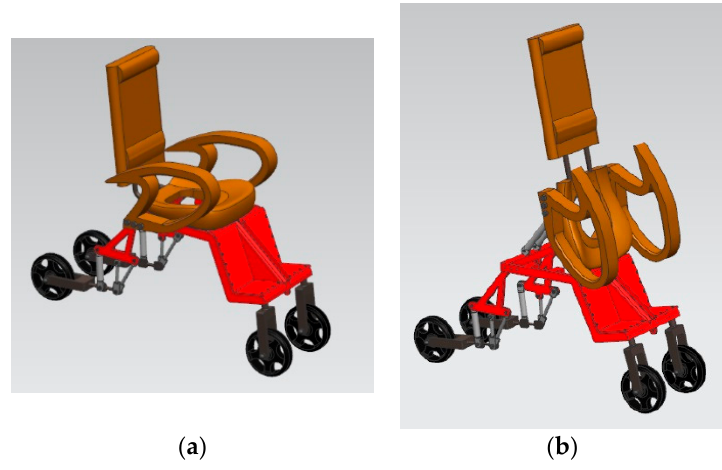
Figure 14. Function chain of the second design concept.